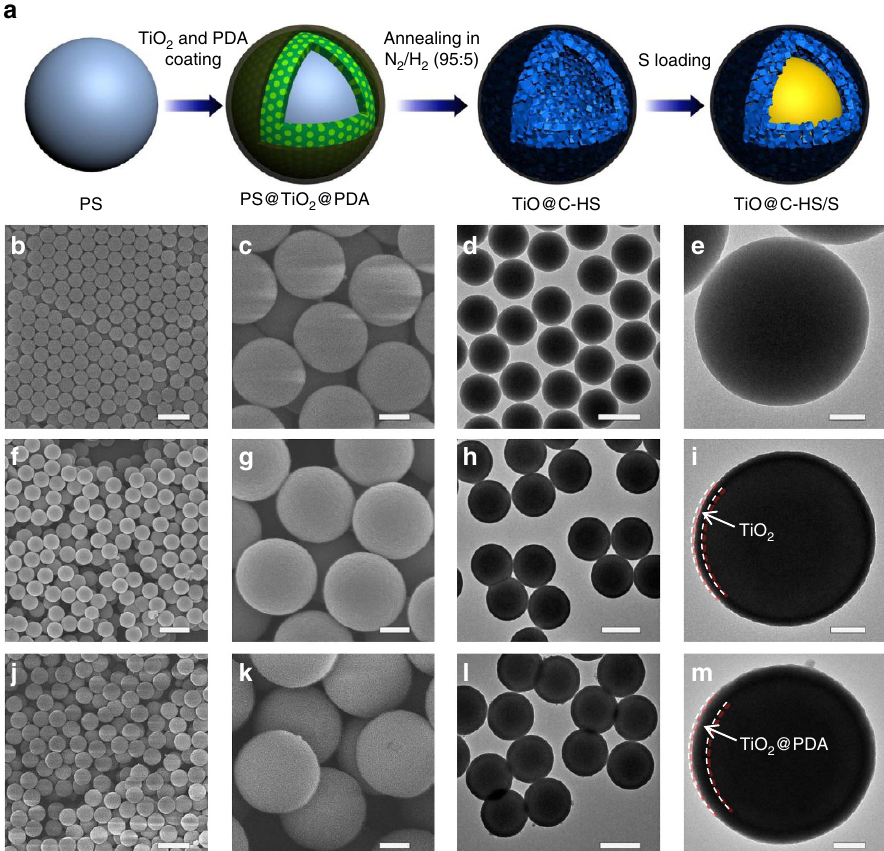
Figure 2 | Synthesis process of the TiO@C-HS/S composite. ( a ) Schematic illustration of the synthesis process of the TiO@C-HS/S composite. SEM and TEM images of ( b – e ) PS spheres, ( f – i ) PS@TiO 2 core-shell spheres and ( j – m ) PS@TiO 2 @PDA spheres. Scale bars, 1 m m ( b , f , j ), scale bars, 200nm ( c , g , k ), scale bars, 500nm ( d , h , l ), scale bars, 100nm ( e , i , m